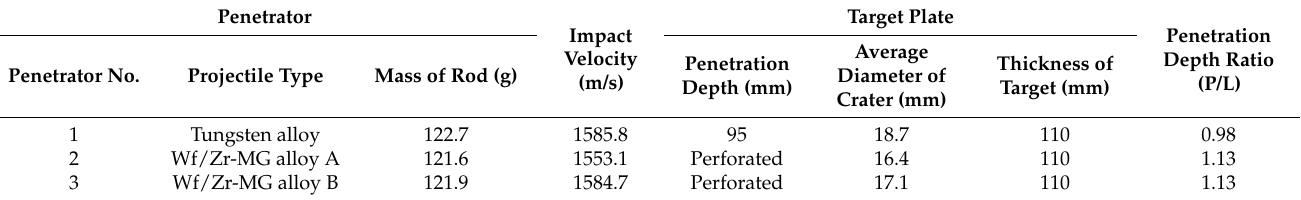
Table 2. Experimental